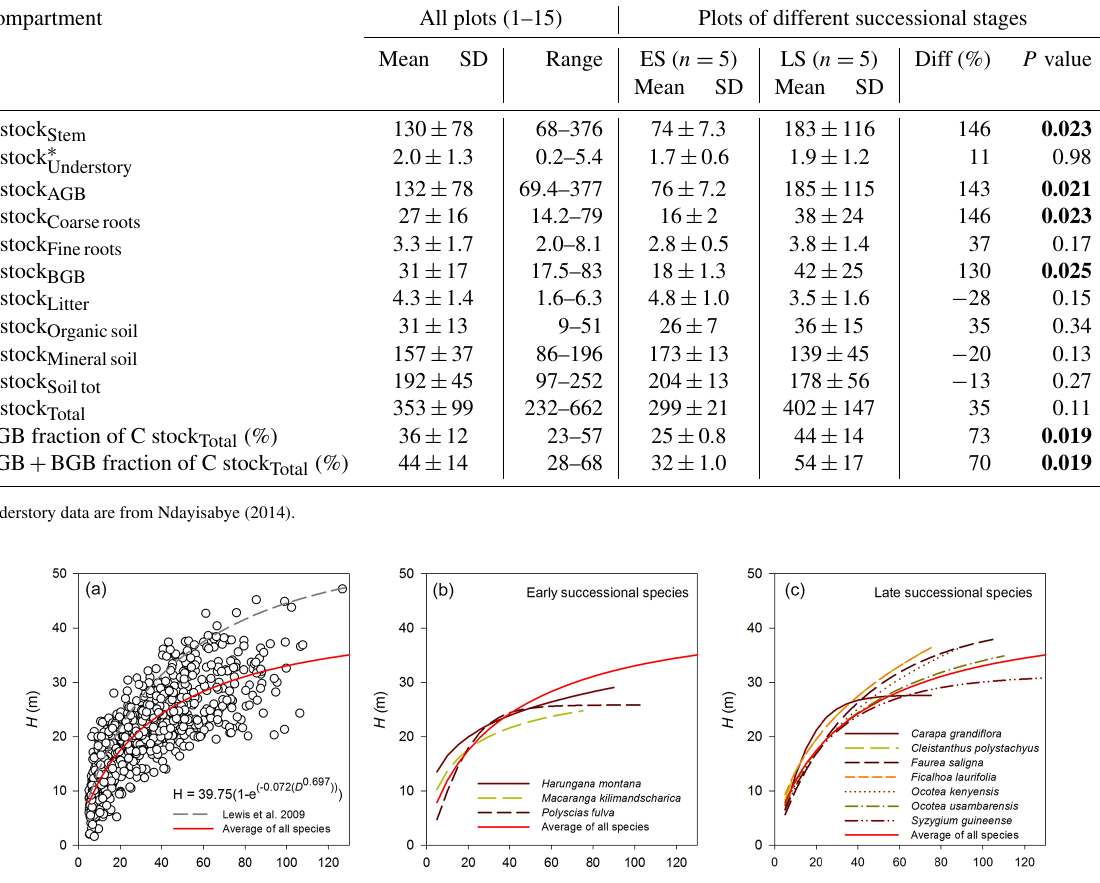
Table 4. Carbon stocks of different ecosystem compartments (means ± SD and plot range) for all plots (1–15) classified as early (ES, n = 5) and late (LS, n = 5) successional. Diff and P value represent the mean differences and the results of a t test of the difference between ES and LS, respectively. For calculating carbon stock (C stock) in the different compartments we used measured values for each fraction of litter (37.3–51.3%C), organic soil (26.0–49.6%C), mineral soil (1.3–9.9%C) and literature values for wood (47.4%C, Martin and Thomas, 2011) and for others we assumed 50%C. AGB is above-ground biomass; BGB is below-ground biomass; C stock values are in MgCha − 1 . Bold value, P < 0 . 05.